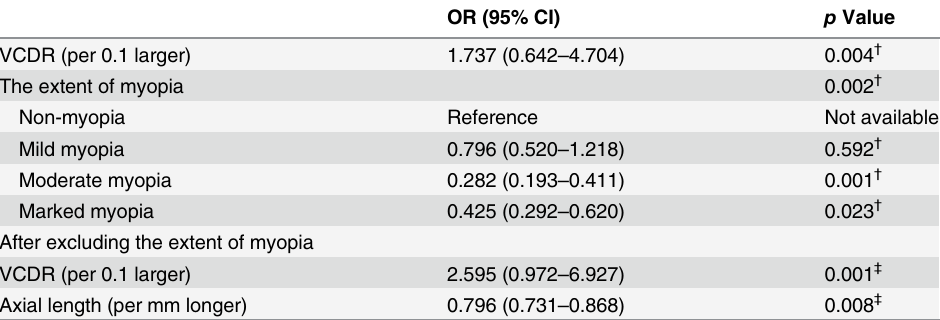
MD = mean defect, OR = odds ratio, CI = con fi dence interval, VCDR = vertical cup-to-disk ratio. † Candidate risk factors included: age, gender, right/left eye, central corneal thickness, BCVA (logMAR), vertical cup-to-disk ratio, baseline IOP, mean follow-up IOP, IOP reduction, IOP reduction percentage, initial MD, follow-up period, spherical equivalent, axial length, and the extents of myopia; ‡ Candidate risk factors included: age, gender, right/left eye; central corneal thickness, BCVA (logMAR), vertical cup-to-disk ratio, baseline IOP, mean follow-up IOP, IOP reduction, IOP reduction percentage, initial MD, follow-up period, spherical equivalent, and axial